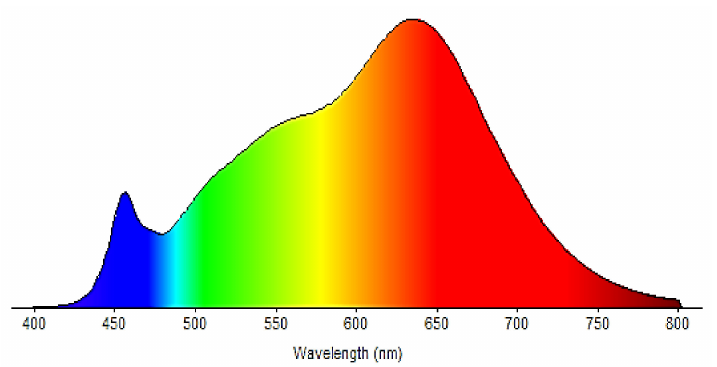
Figure 3. Emission spectrum of LED lamps (Stairville LED Power-Flood 100 W). For testing in the UV-Vis domain (simulated sunlight) an ATLAS NXe 2000 HE xenon arc lamp was used (emission spectrum exclusively in the range 300 nm ≤ λ ≤ 800 nm, with an irradiance E = (42 ± 0.5 W/m 2 ) (measured at the level of the test sample)). For the test, a quantity of m = 0.07 ± 0.01 g photocatalytic antimicrobial paint ALINNA was deposited on the microscope slides, with a layer thickness g = 0.03 ± 0.005 mm, and the area covered was A = 16 ± 0.5 cm 2 . The photochemical conversion obtained in mole units per square meter and hour (mole/(m 2 h)) was measured. All devices that encounter methylene blue solutions (MBs) are made of materials that negligibly adsorb MB (glass, stainless steel, polyethylene, polypropylene, polyacrylate, or certain low-emission silicones).